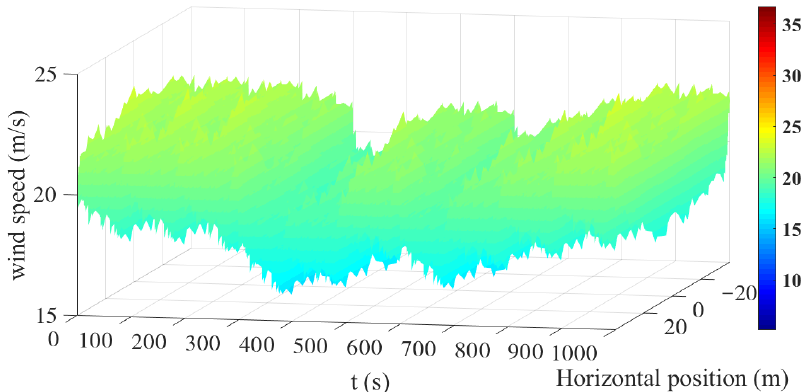
Figure 15. The wind speed in FAST simulation.